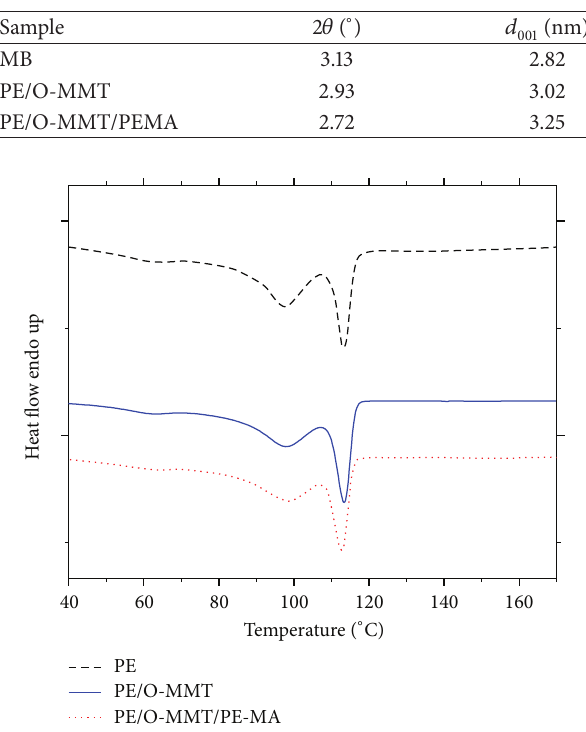
Table 3: 2 𝜃 and 𝑑 data for the different nanocomposites. 001